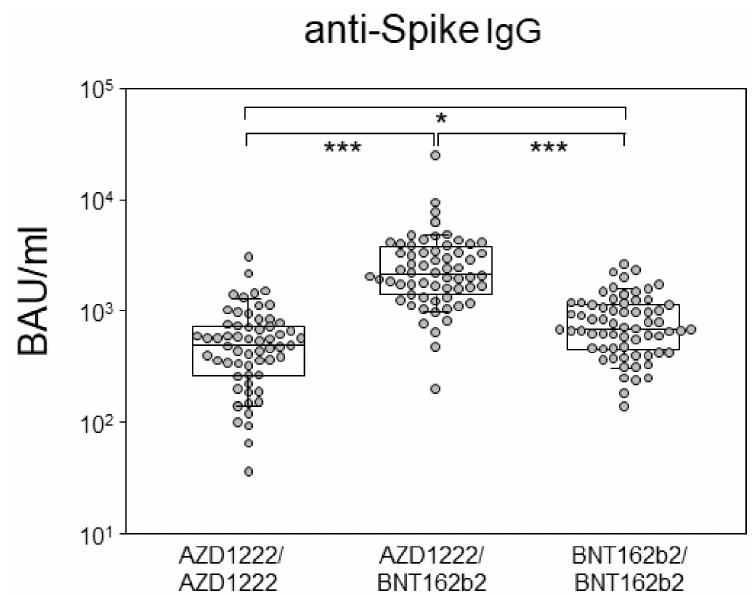
Figure 1. Heterologous prime-boost combining AZD1222 and BNT162b2 resulted in highest antibody levels at six months. Box plots compare anti-spike IgG antibody levels in BAU/mL six months into homologous or heterologous prime-boost vaccinations using AZD1222 and BNT162b2. Each dot represents one individual, while the boxplots show the medians, 25th and 75th percentiles, as well as the 95th percentile via the whiskers. The p -value resulting from the Kruskal–Wallis test was <0.0001, and results from Dunn ´ s multiple comparisons test are indicated by asterisks and correspond to p < 0.05 (*), and p < 0.001 (***).